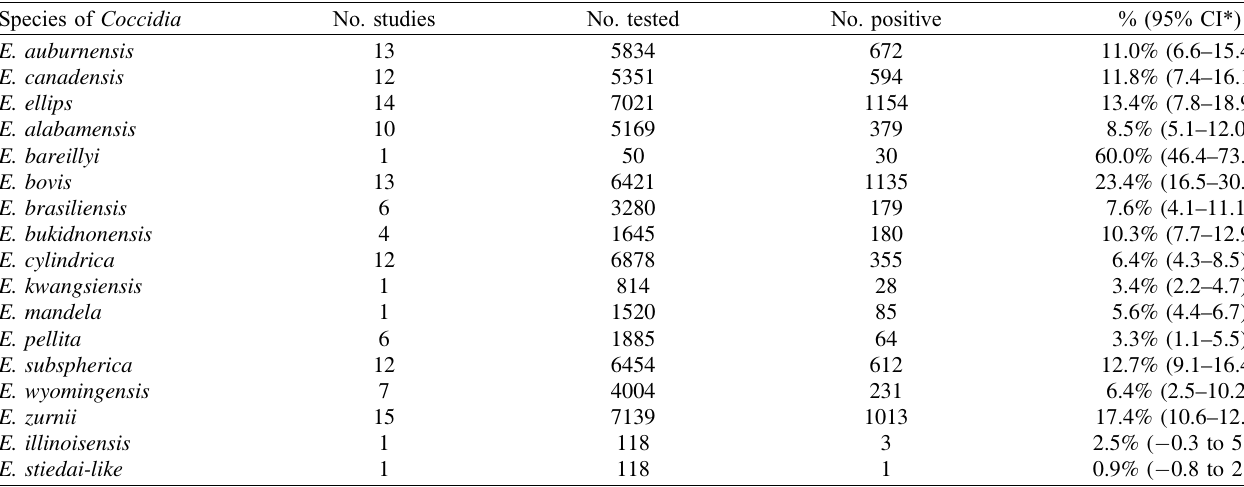
Table 4. Pooled prevalence of different Eimeria species in mainland China. Species of